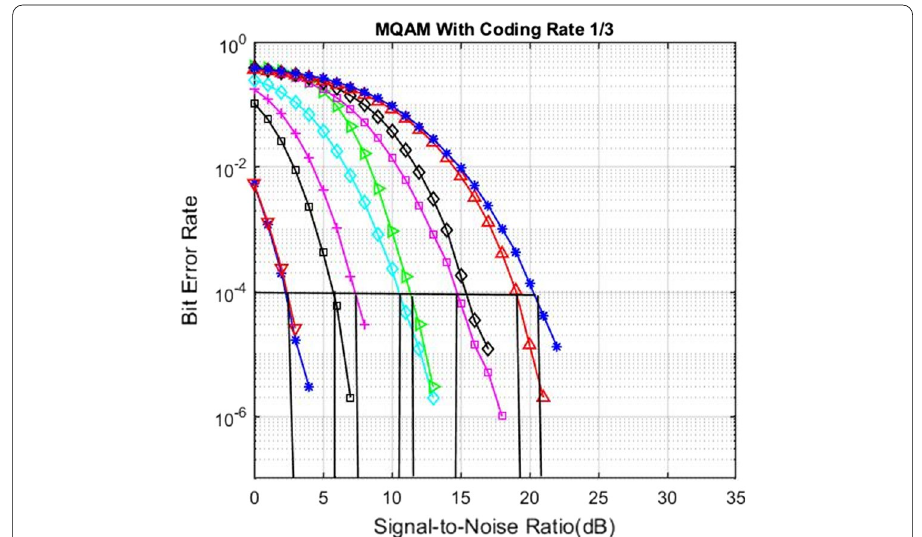
Fig. 3 Generation of I/O pairs for different modulation schemes with 1/3 code-rate. Shows how we get the desired coding rate, code-rate 1/3 for this particular example, and different modulation order-BER plot